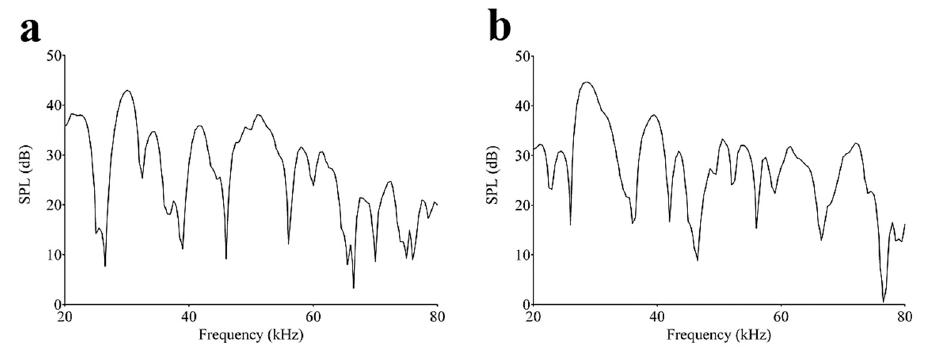
Figure 10. Frequency response of the ( a ) Archimedean and ( b ) Fibonacci spiral-like transducers excited by 150 V, 100 μ s rectangular pulse.